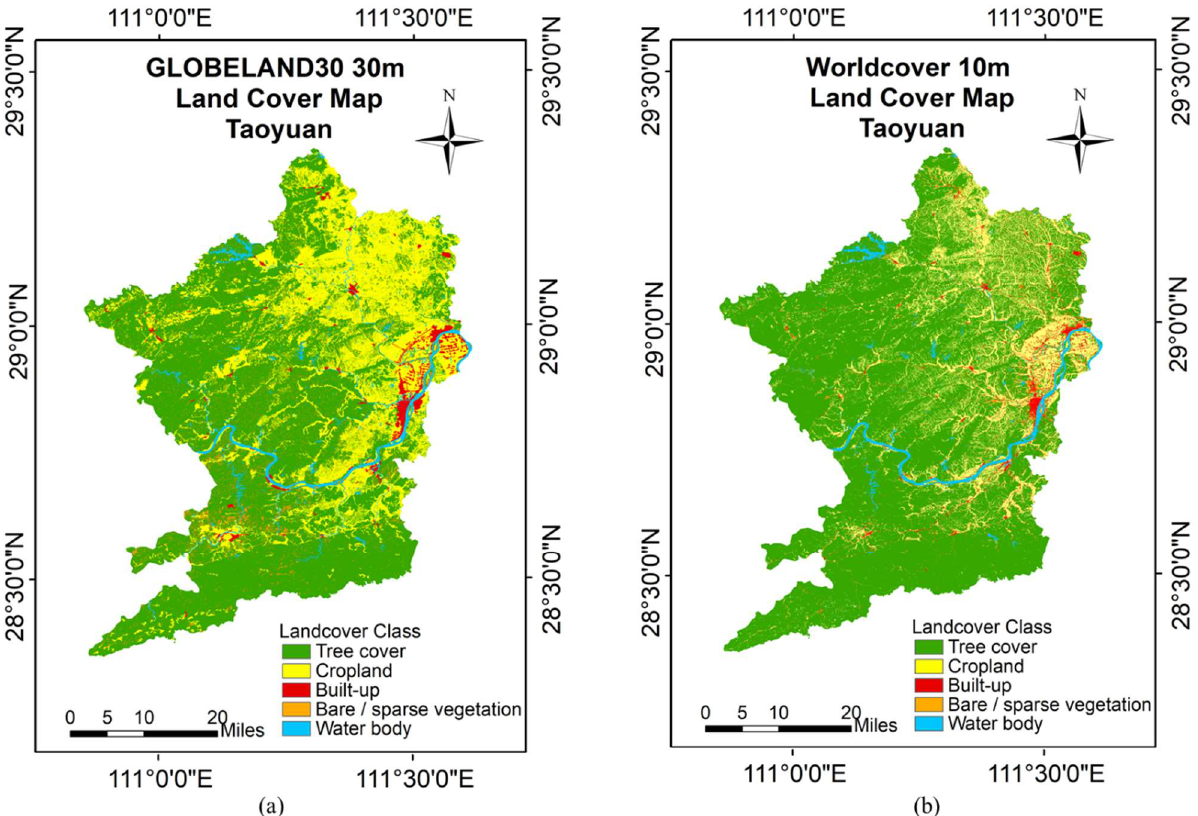
Figure 2. ( a ) Taoyuan 30 m land cover map. ( b ) Taoyuan 10 m land cover map.